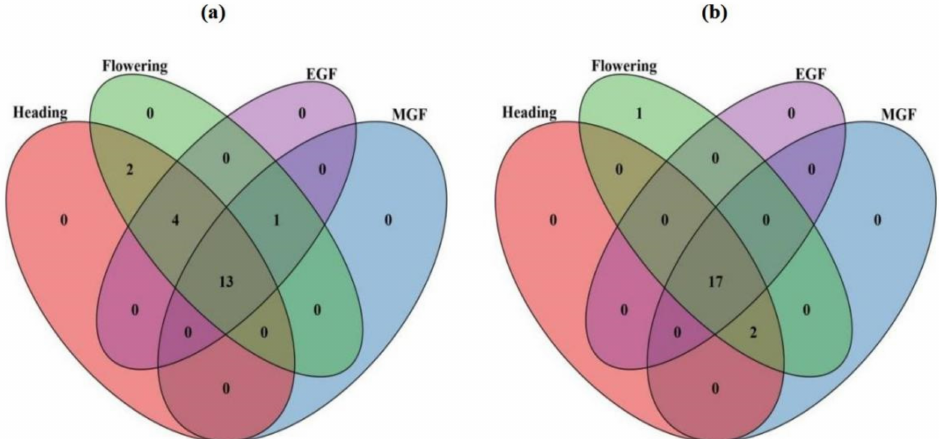
Figure 5. The Venn diagram of the vegetation indices with heritability greater than 0.5 for each growth stage; ( a ) full irrigation treatment; ( b ) limited irrigation treatments. Abbreviations: EGF, early grain filling; MGF, mid-grain filling.